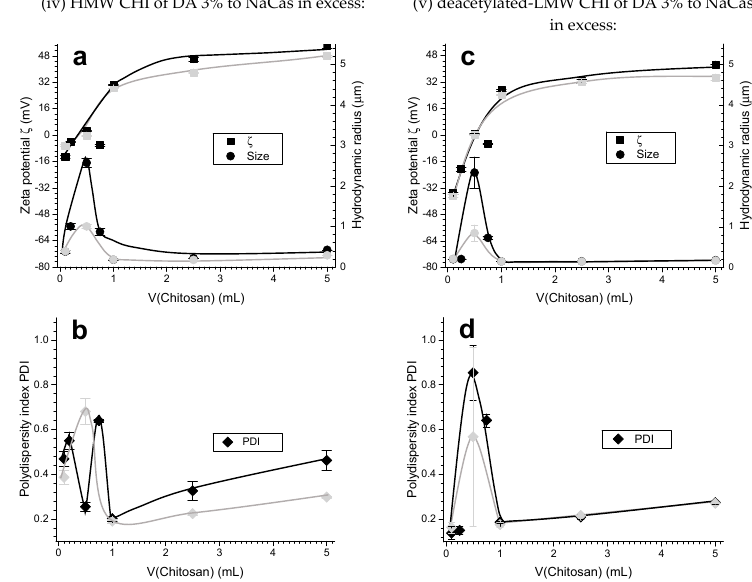
Figure 7. Zeta potential ζ , hydrodynamic radius (size) and its polydispersity index PDI respectively obtained for the experiments of the Case II (caseinate in excess): (iv) HMW CHI of low DA = 3% added to NaCas ( a , b ); (v) deacetylated-LMW CHI of low DA = 3% added to NaCas ( c , d ). Black curves show the characteristics of the chitosan-caseinate PEC colloidal system obtained in the first week; grey curves show the results obtained after two weeks aging at room temperature.